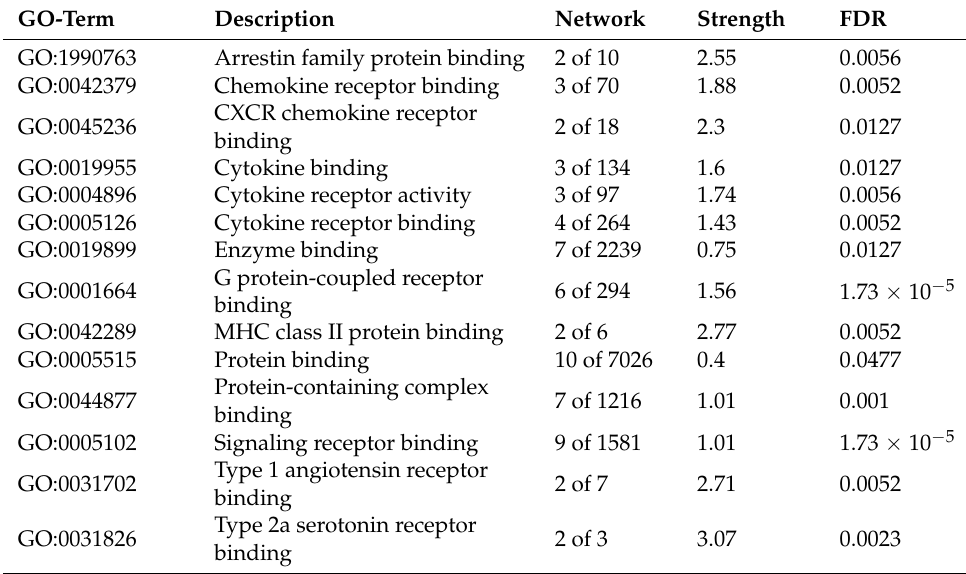
Figure 7. CXCR4 protein–protein interaction analysis. The length of an interaction between two proteins is one way to measure how far apart the proteins are. The nodes represent the proteins, and the edges represent their interactions. The size of the nodes corresponds to the degree of connectivity, with larger nodes representing more highly connected proteins. The nodes’ colors indicate the proteins’ functional categories. Table 1. Gene ontology showing the molecular function of CXCR4 protein.